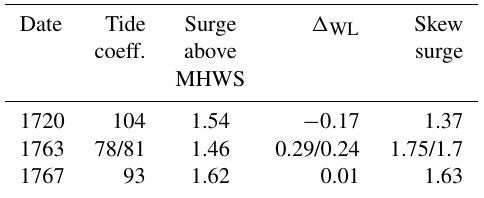
Table 4. Historical skew surges induced by the 1720–1767 events. Heights are given in